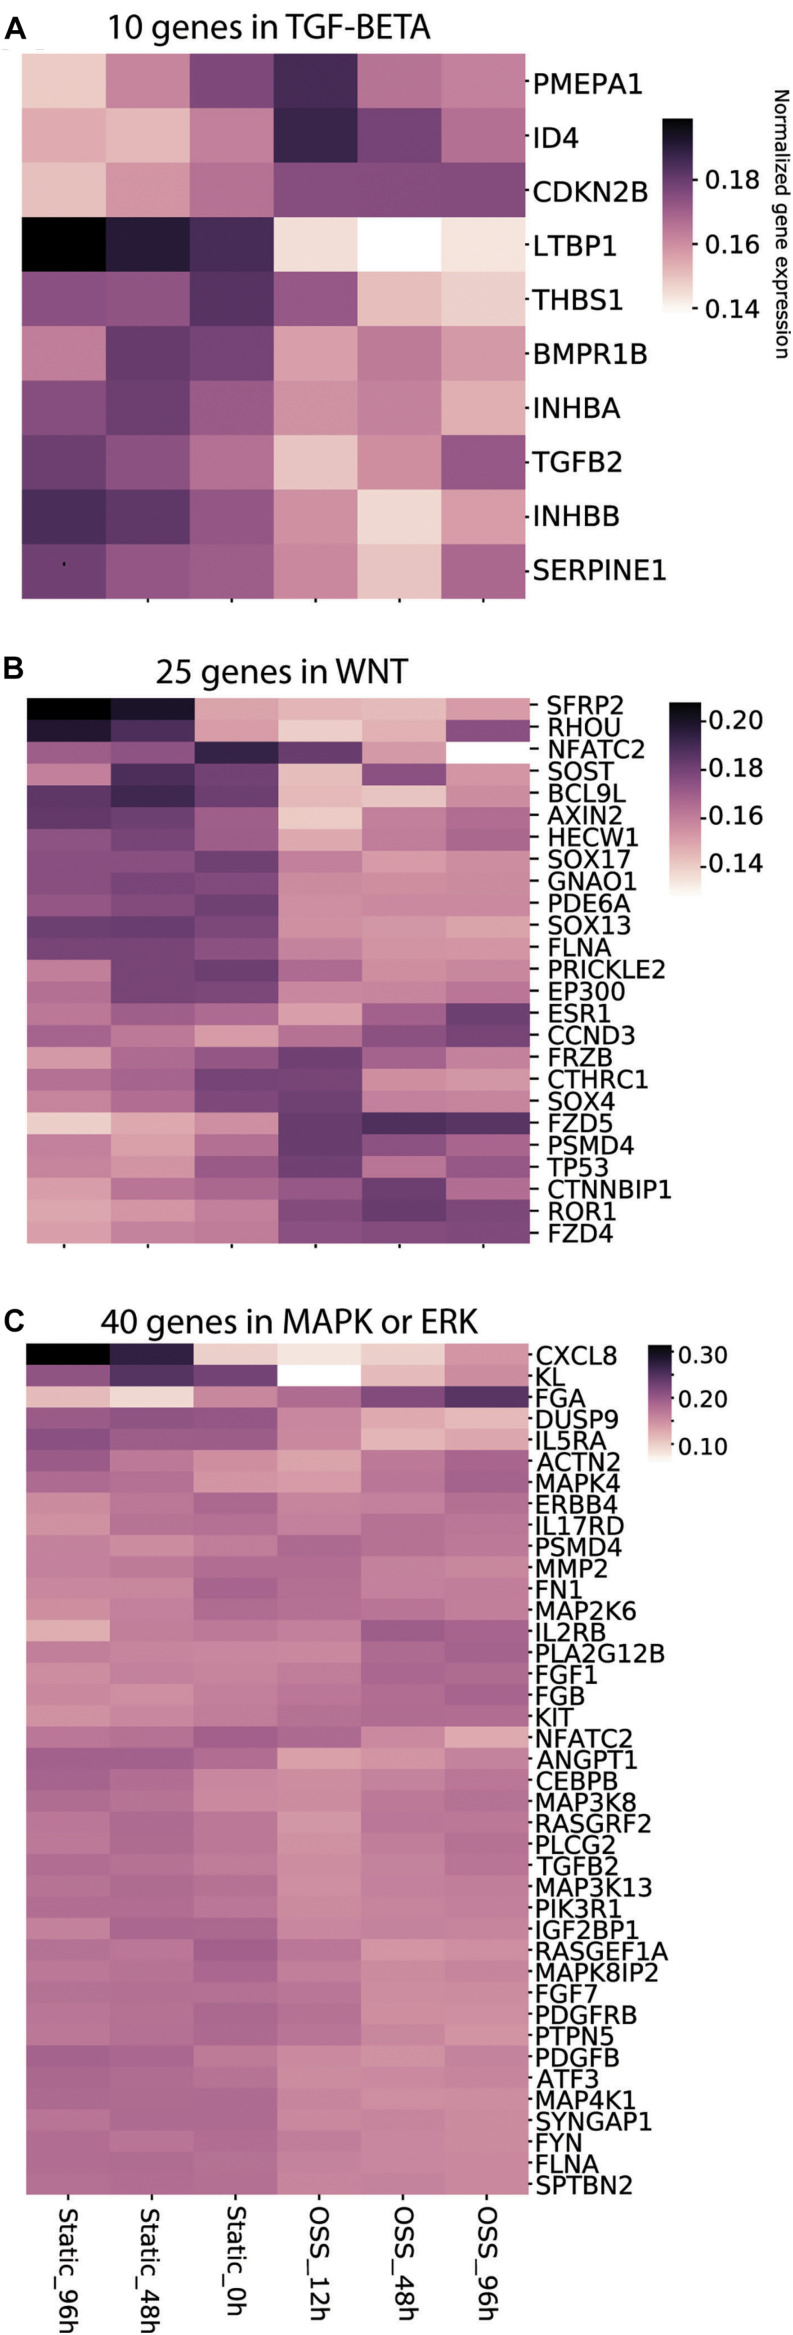
Culture-dependent temporal gene expression changes in mechanosensitive signaling pathways. Heat maps of the gene expression profile of gene sets defined using keywords (A) TGF-β, (B) Wnt, and (C) MAPK/ERK are plotted for cells incubated for 96, 48, and 0 h under Static conditions or 12, 48, and 96 h under OSS.